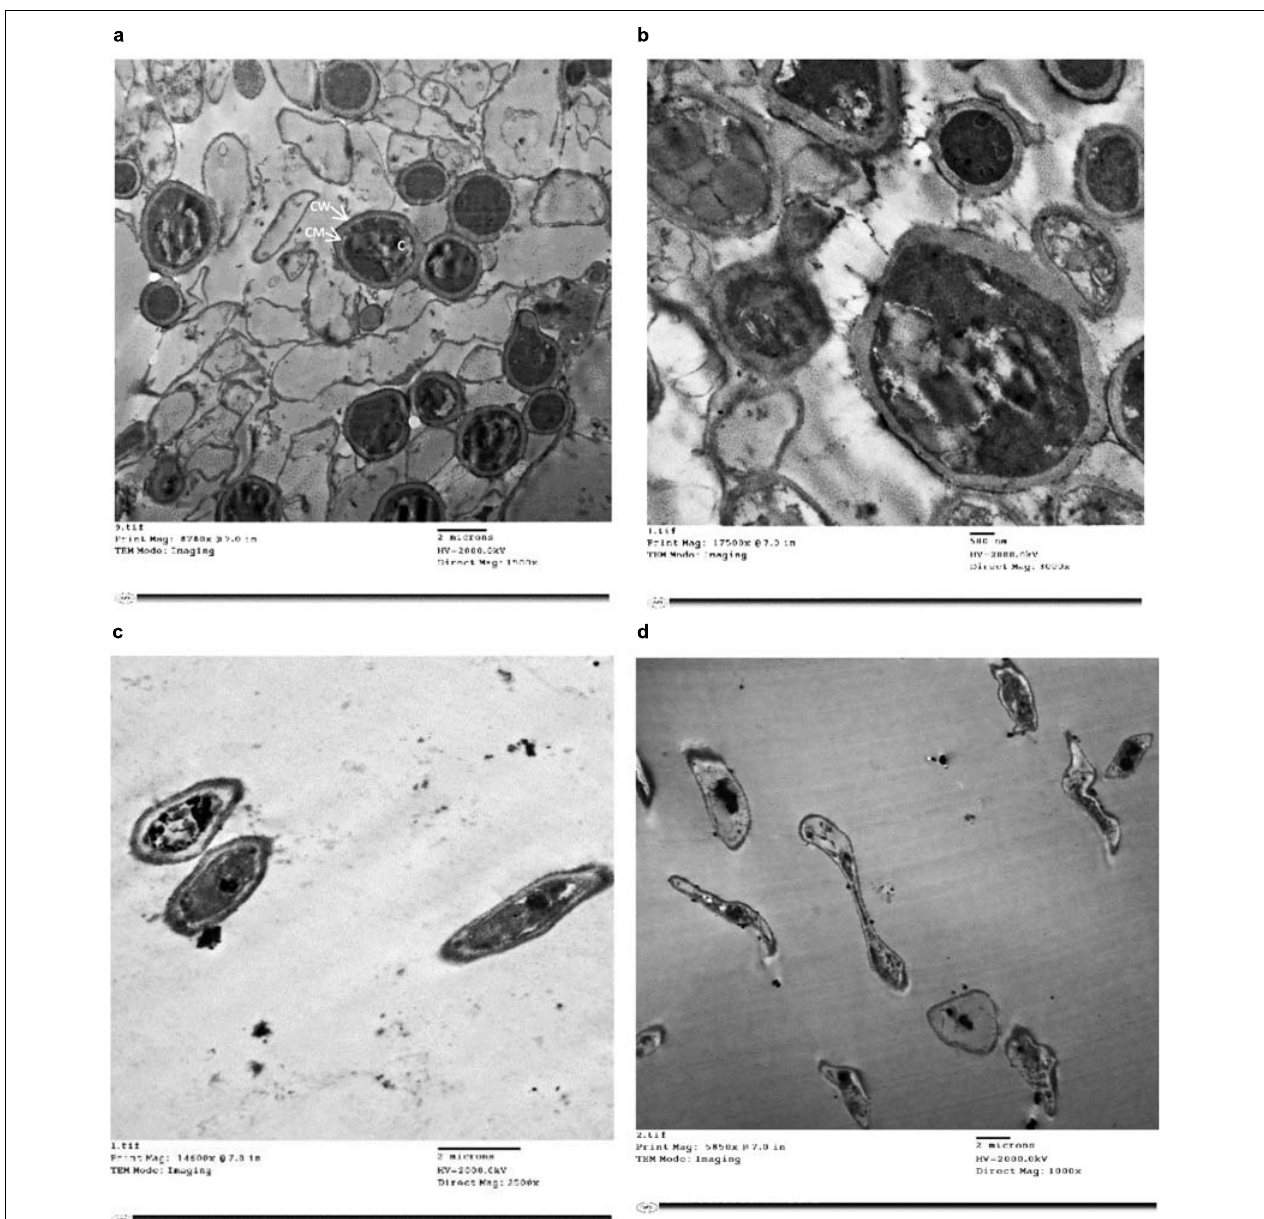
FIGURE 2 | TEM photographs of treated and untreated T. rubrum showing (a) a normal morphology with intact cell walls, membranes and dense cytoplasm, (b) cells treated with 20% urea displaying slight cell wall irregularities and hazy edges but the cytoplasm remained dense, (c) cells treated with 1/2 MIC of miconazole showing less dense cytoplasm, (d) cells treated with a combination of 0.003 mg/L of miconazole/20% of urea showing degeneration. CW; cell wall, CM; cell membrane, C;